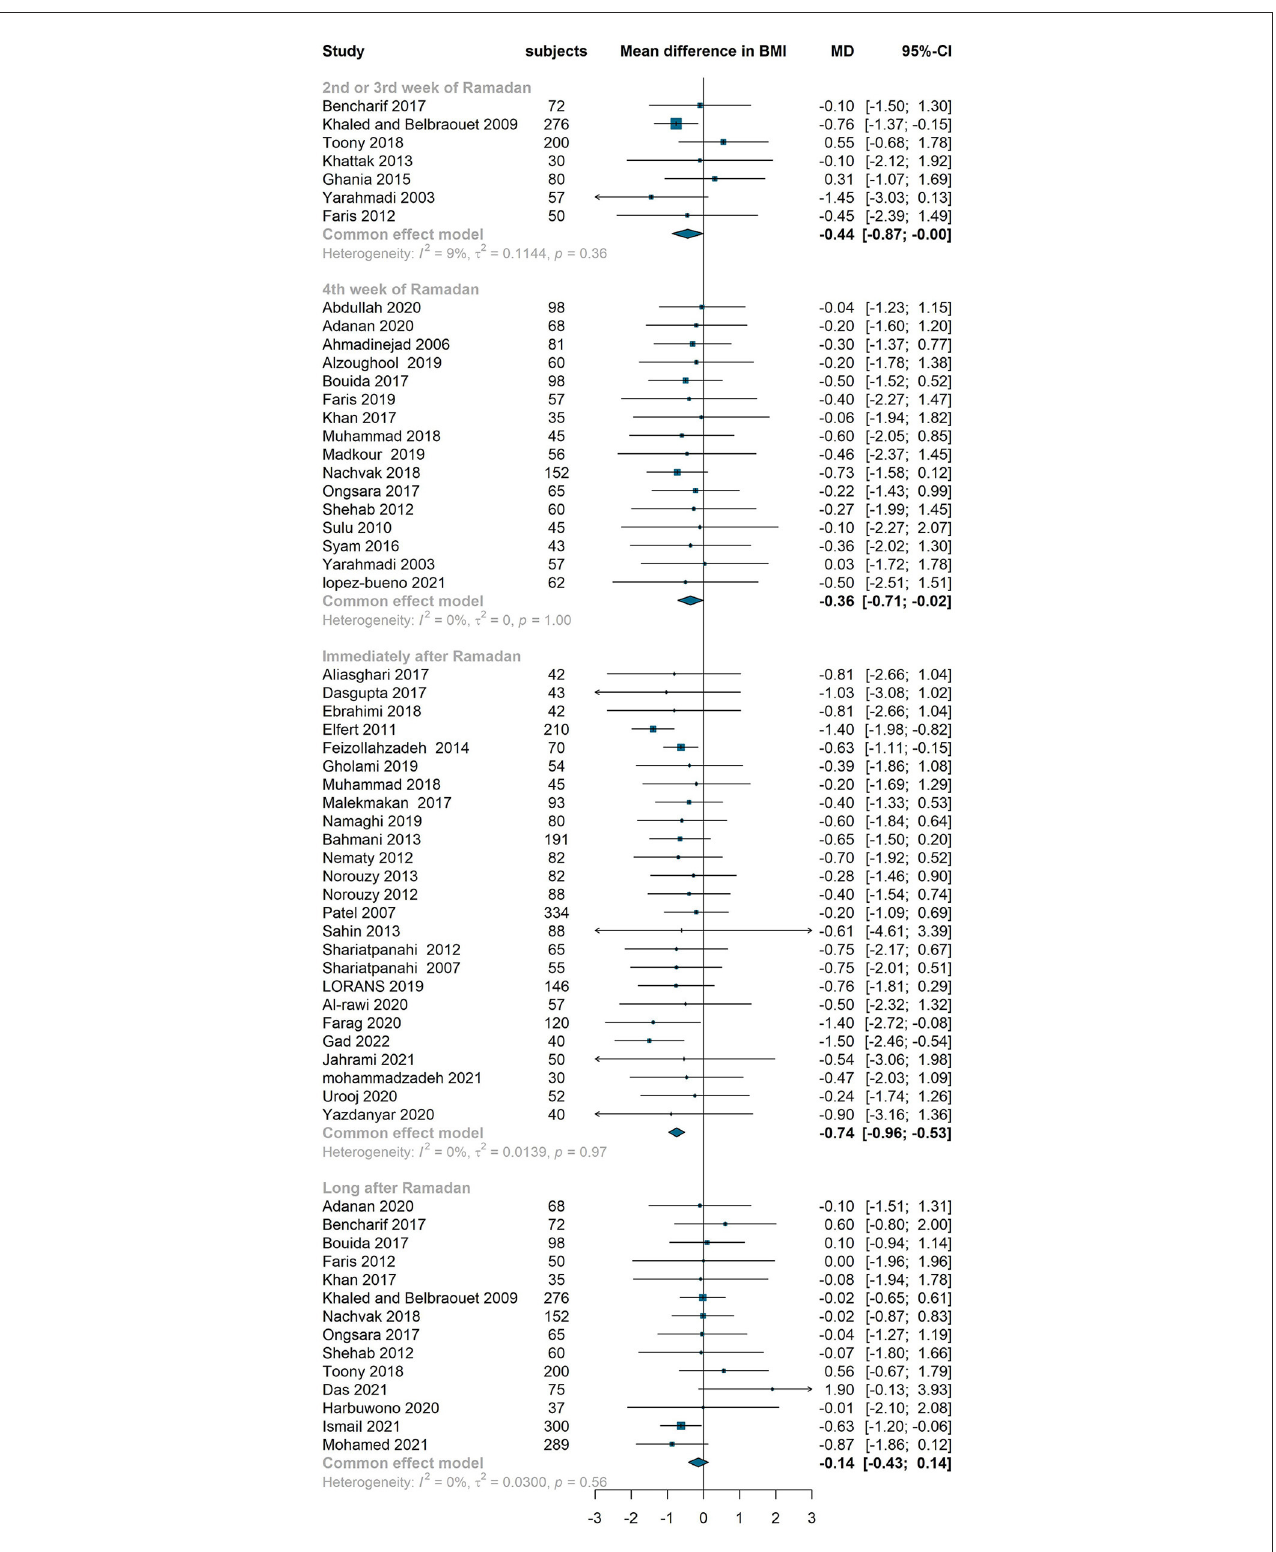
FIGURE3 Fixed effect meta-analysis of RIF effect on